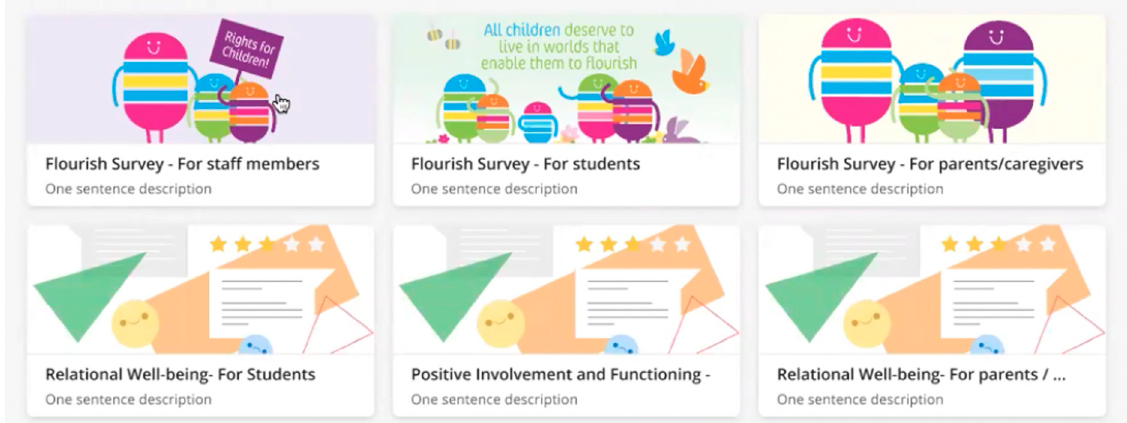
Figure 10. Flourish Survey Options—Nurture Beta Web Platform.